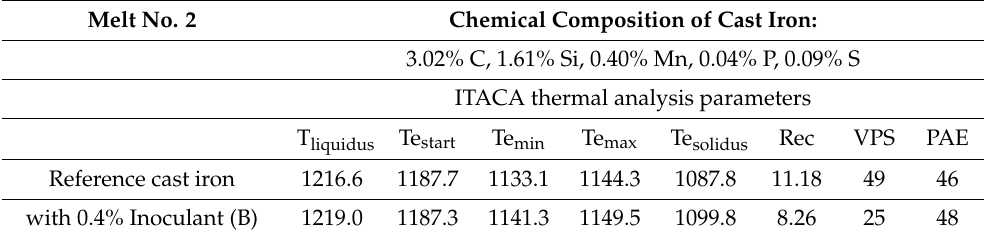
Figure 17. Grey cast iron (with 0.014% S content) with addition of 0.4% Inoculant (A) and iron powder (0.2%): ( a ) sample etched with Picral reagent; ( b ) non-etched sample; ( c ) changes in cast iron temperature (in time, sec.) during crystallisation and cooling of casting according to ITACA system. Table 7. Cast iron crystallisation parameters obtained in thermal analysis by ITACA method in Melt No.